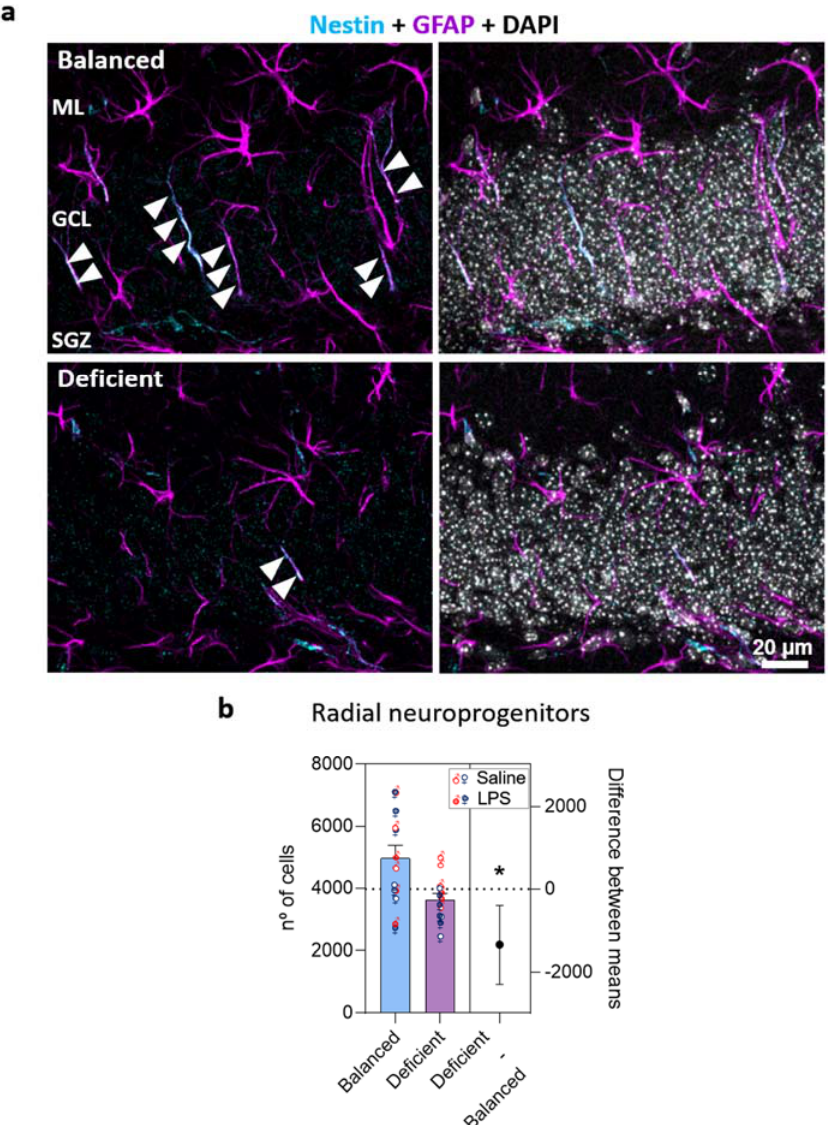
Figure 3. The n ‐ 3 PUFA ‐ deficient diet reduced the number of radial progenitors in the dentate gyrus (DG). ( a ) Confocal images (maximum intensity projections, z = 13.8 μ m) of the DG of the hippocam ‐ pus showing radial neuroprogenitors identified by the expression of nestin (cyan) and GFAP (glial fibrillary acidic protein, magenta) and the presence of an apical process (arrowheads) crossing the granular cell layer of the DG. Additional images from each condition are available in Supplementary Figure S2. ( b ) Estimation plots showing the diet effect size (difference between group means) and its associated 95% confidence interval (right axis). The number of radial neuroprogenitors was re ‐ duced in mice fed with the n ‐ 3 PUFA ‐ deficient diet compared to mice fed with the balanced diet. No effects of LPS or sex were detected. * p < 0.05 (statistics detailed in Supplementary Data).